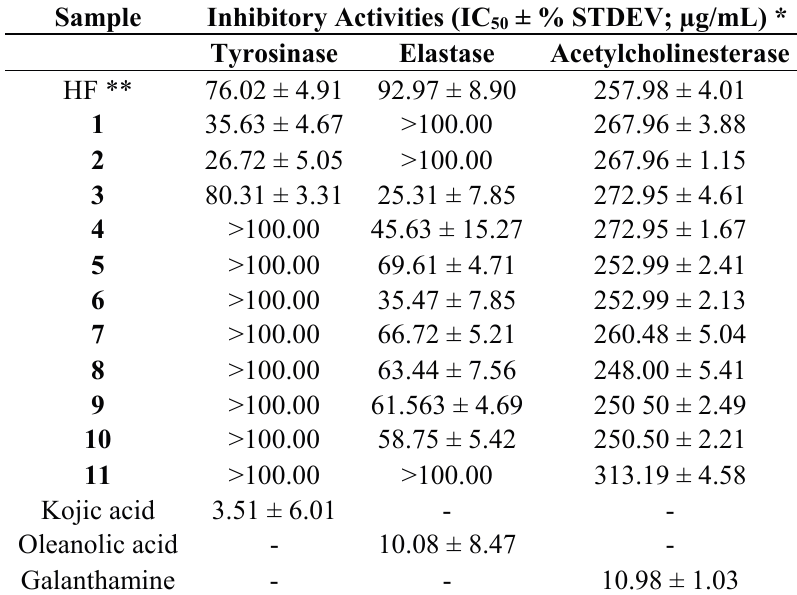
Table 4. Enzyme inhibitory effect of a methanolic extract of H. niveum and its